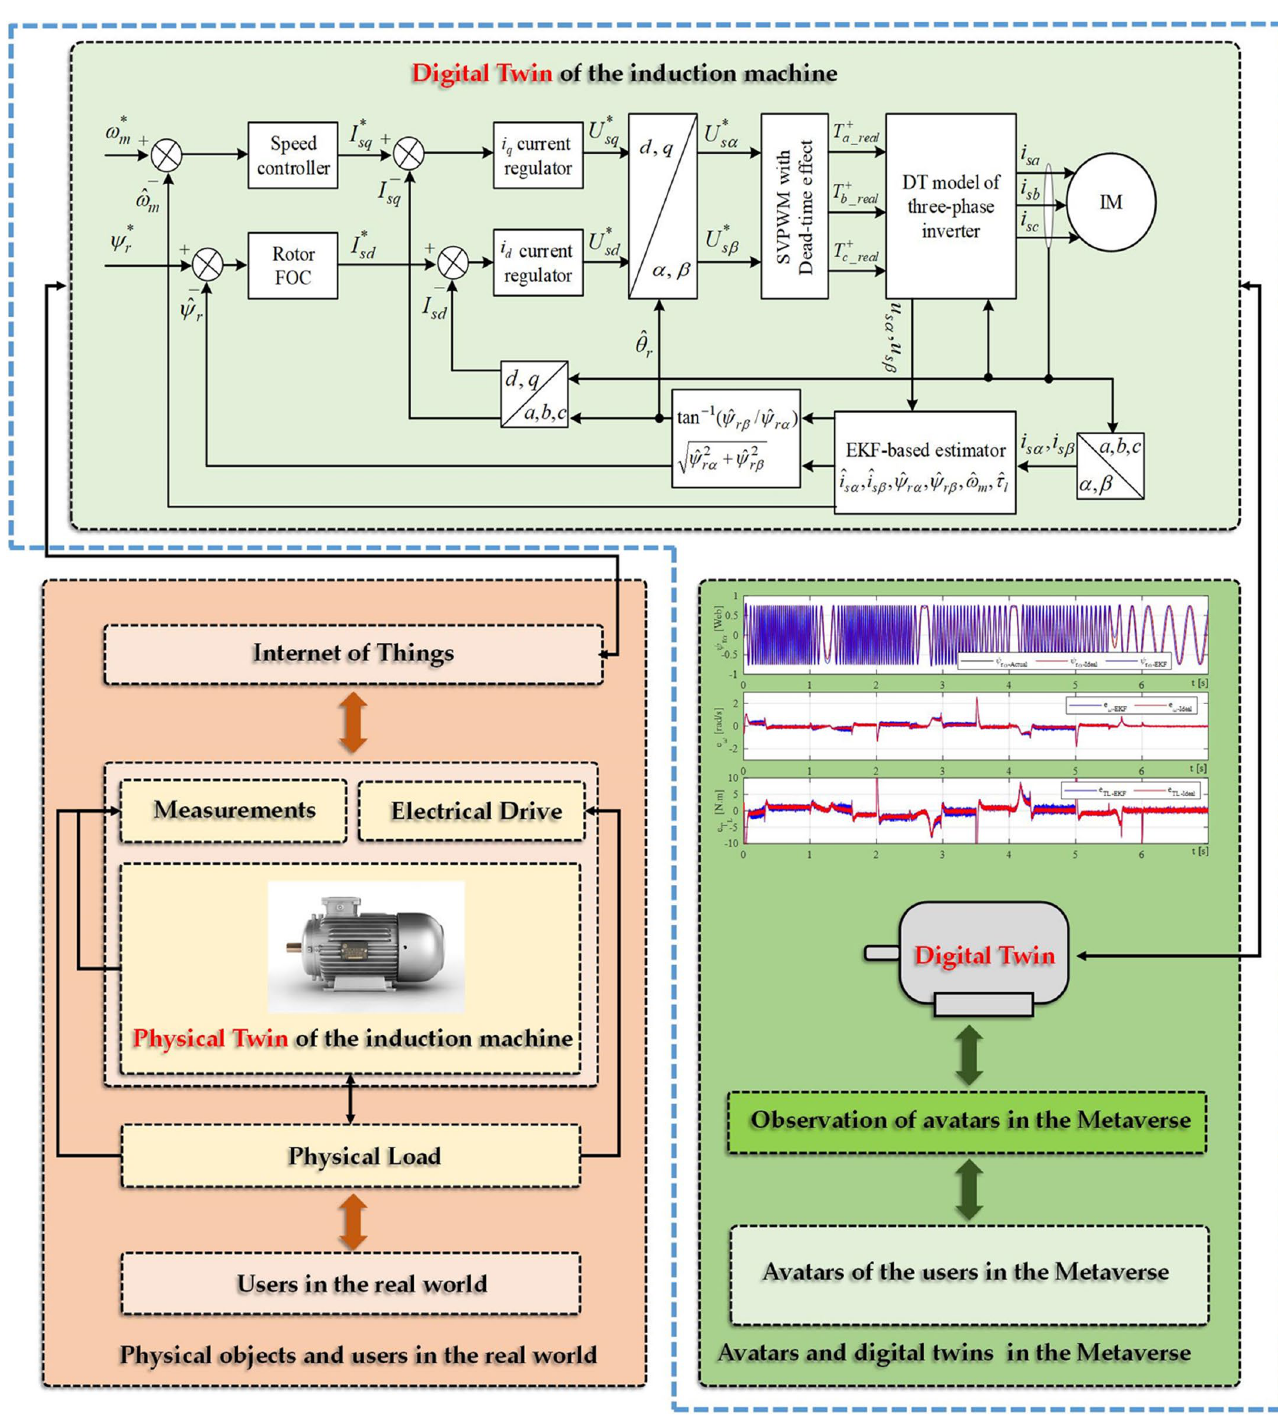
Figure 1. The representation of a physical electrical drive and its digital twin within a Metaverse platform. The use of the term digital twin refers to the concept of creating the digital counterpart, or twin, of the physical electric drive. In this context, the physical electrical drive and its digital twin are existing simultaneously within the Metaverse platform, creating a bridge between the physical and digital realms. The figure highlights the innovative approach of using the Metaverse platform to bring together both the physical and digital aspects of an electrical drive.